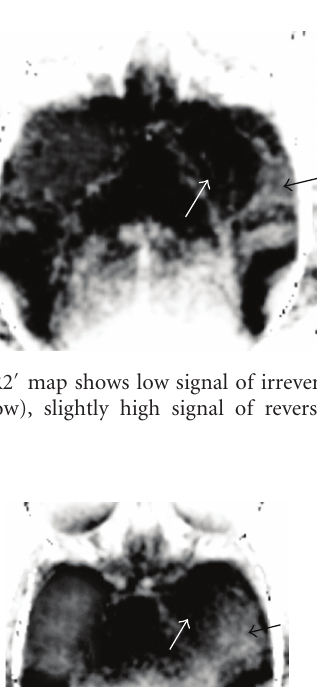
Figure 12: Reperfusion time evolution of rR2 (cid:2) shows decreased trend in infarcted core but increased trend in IP and